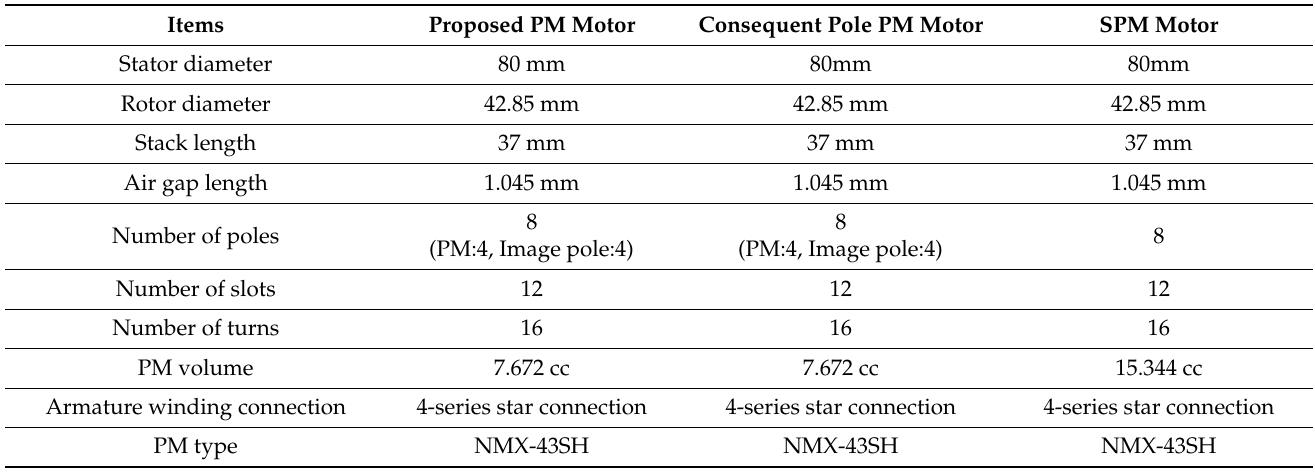
Figure 27. Cross-section of motor model: ( a ) proposed motor; ( b ) consequent pole motor; ( c ) SPM motor. Table 3. Motor specifications of a novel consequent-pole prototype.